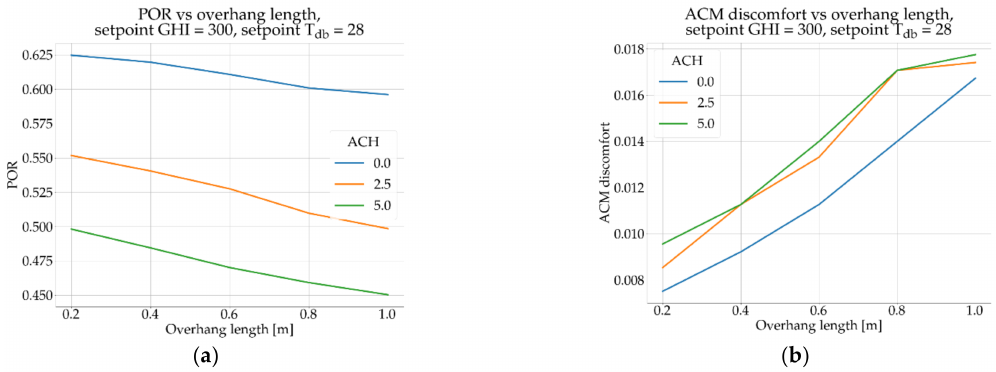
Figure 9. Thermal discomfort expressed with ( a ) POR and ( b ) adaptive categories at varying overhang length and ACH in Torre Pellice.